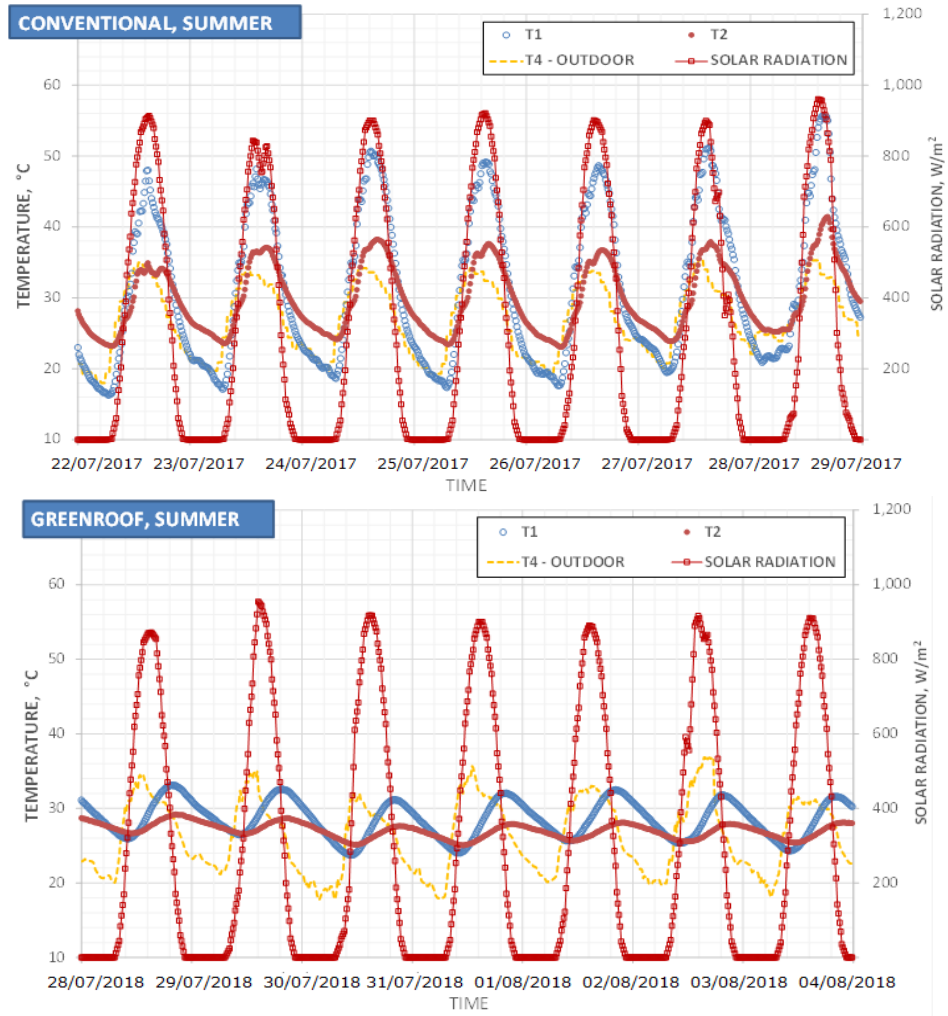
Figure 8. Typical traces for different temperatures and solar radiation in summer period.